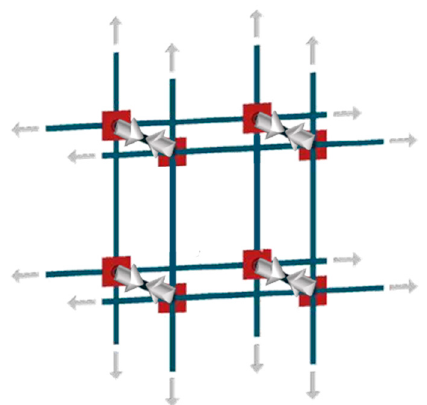
Figure 24. Mechanism of stress transfer in the assumption of perfectly balanced in ‐ plane forces.